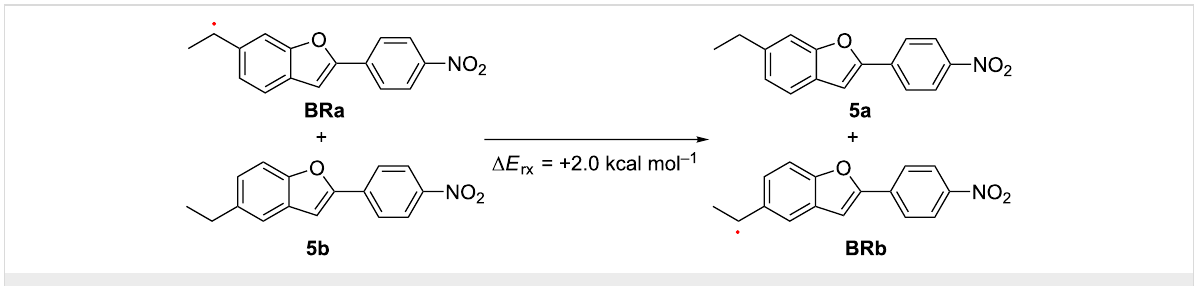
Scheme 4: Isodesmic reaction from BRa and 5b to 5a and BRb .